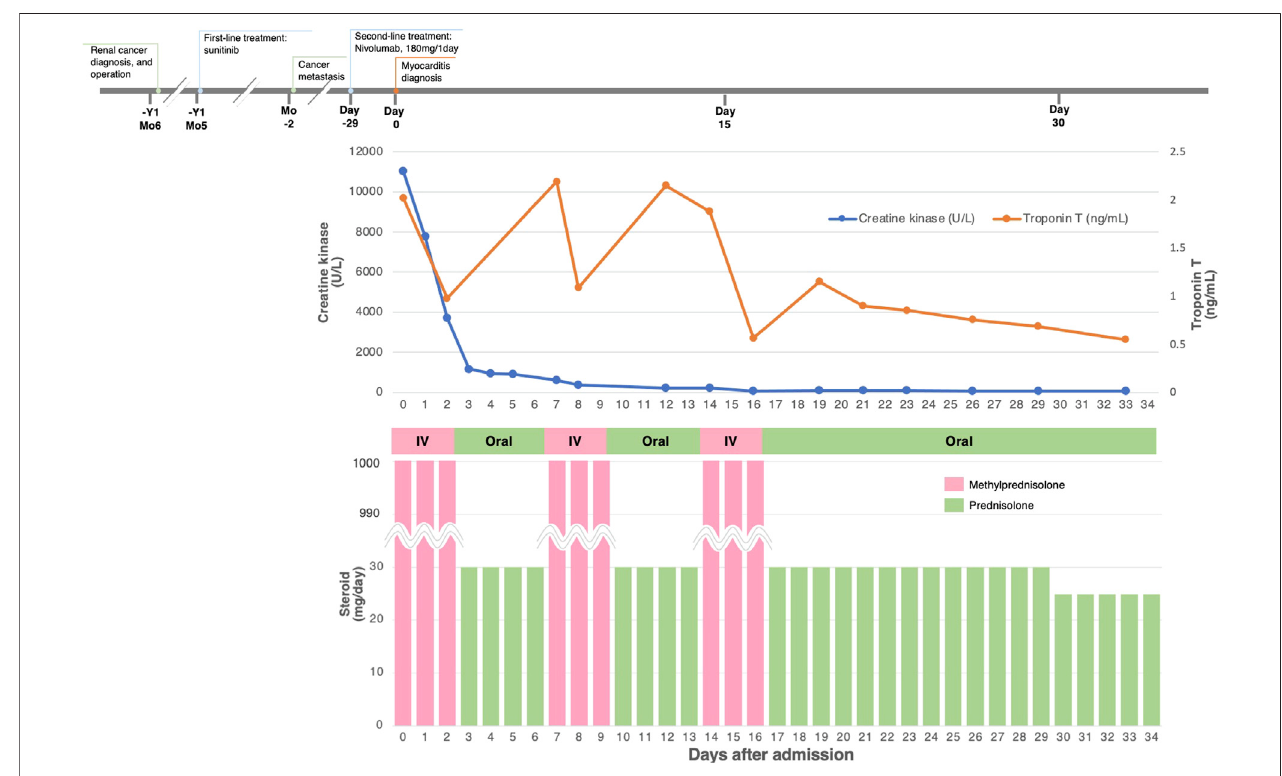
FIGURE 3 | Clinical course and changes in CK and troponin in case